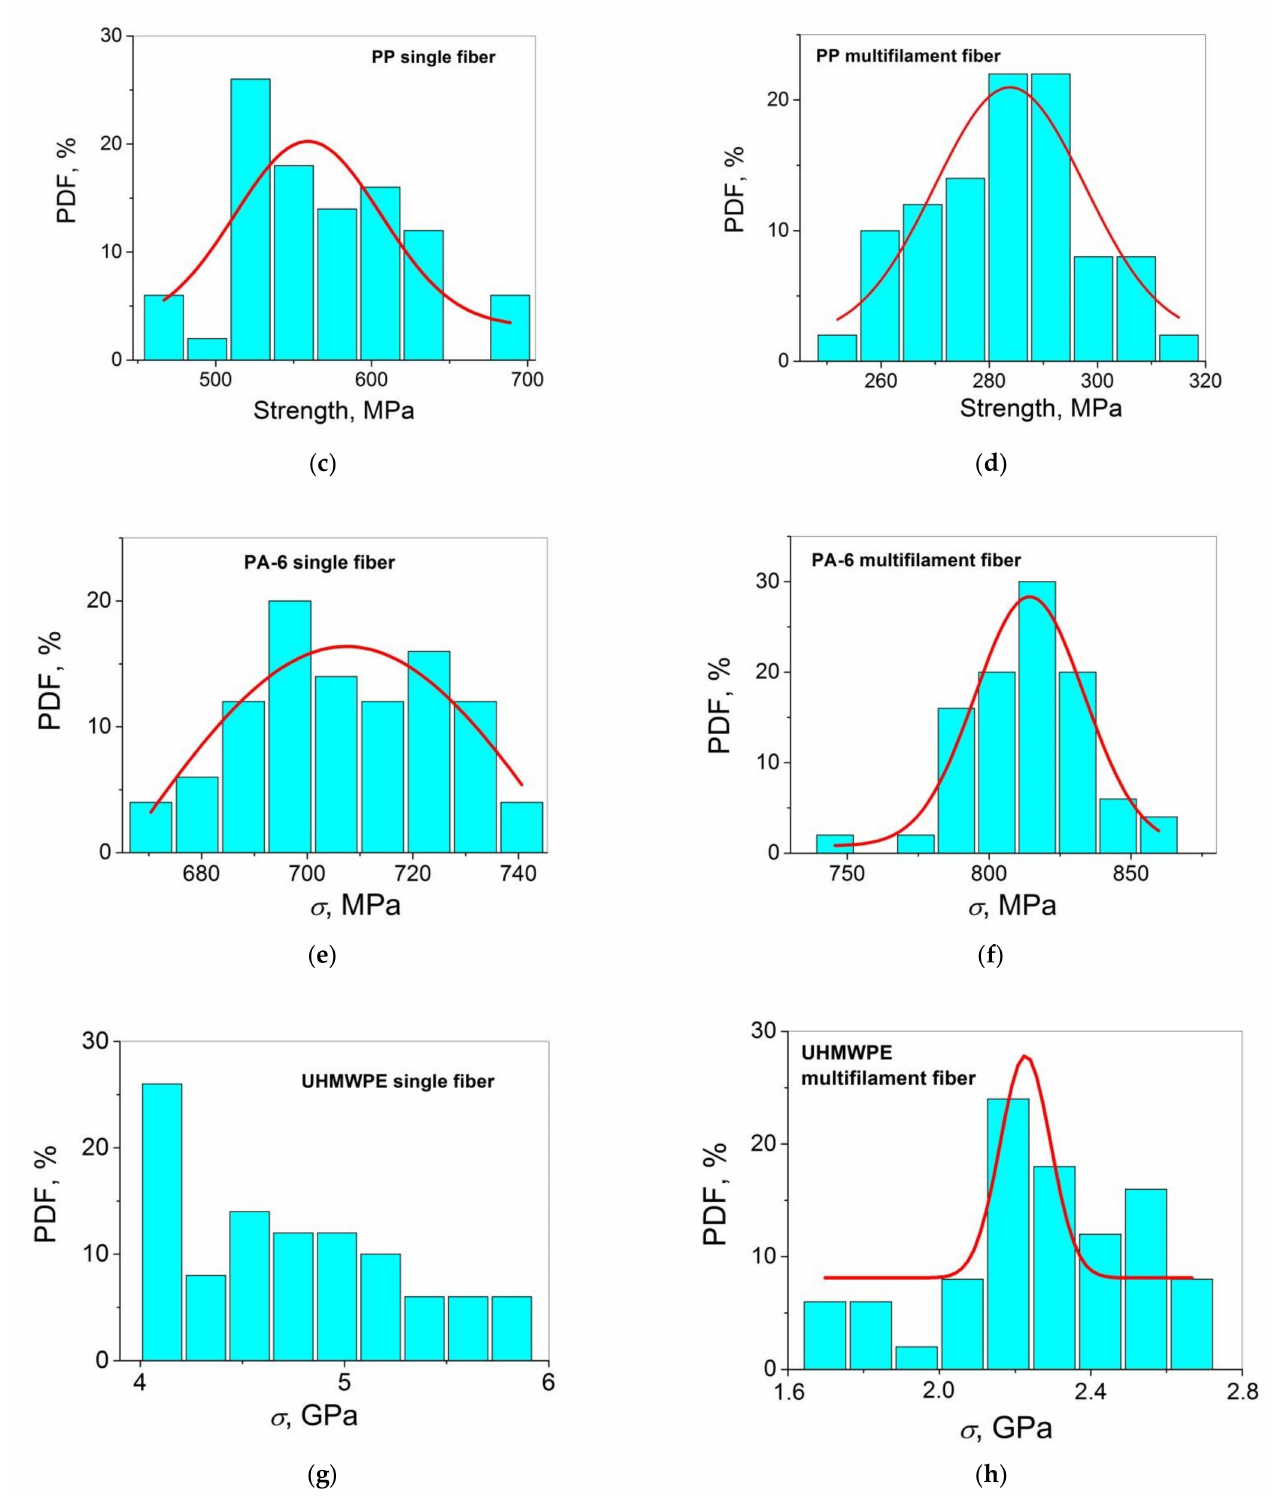
Figure 2. ( a ) Tensile strength σ as a function of sample number n in an ascending order for single and multifilament fibers of UHMWPE, PA 6 and PP; ( b ) Weibull’s plots for the data presented in ( a ), the solid lines are linear fits to the data sets; probability density function (PDF) vs. σ for: ( c ) UHMWPE single fibers, ( d ) UHMWPE multifilament fibers, ( e ) PA 6 single fibers, ( f ) PA 6 multifilament fibers, ( g ) PP single fibers, and ( h ) PP multifilament fibers; the bell curves PDF( σ ) are the Gaussian fitting